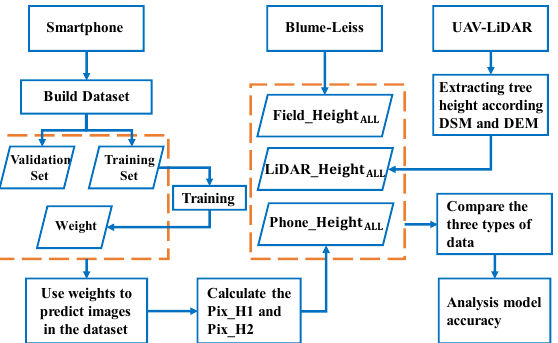
Figure 7. Flow chart for extracting the height of urban forest trees based on a smartphone with the person – tree scale height measurement